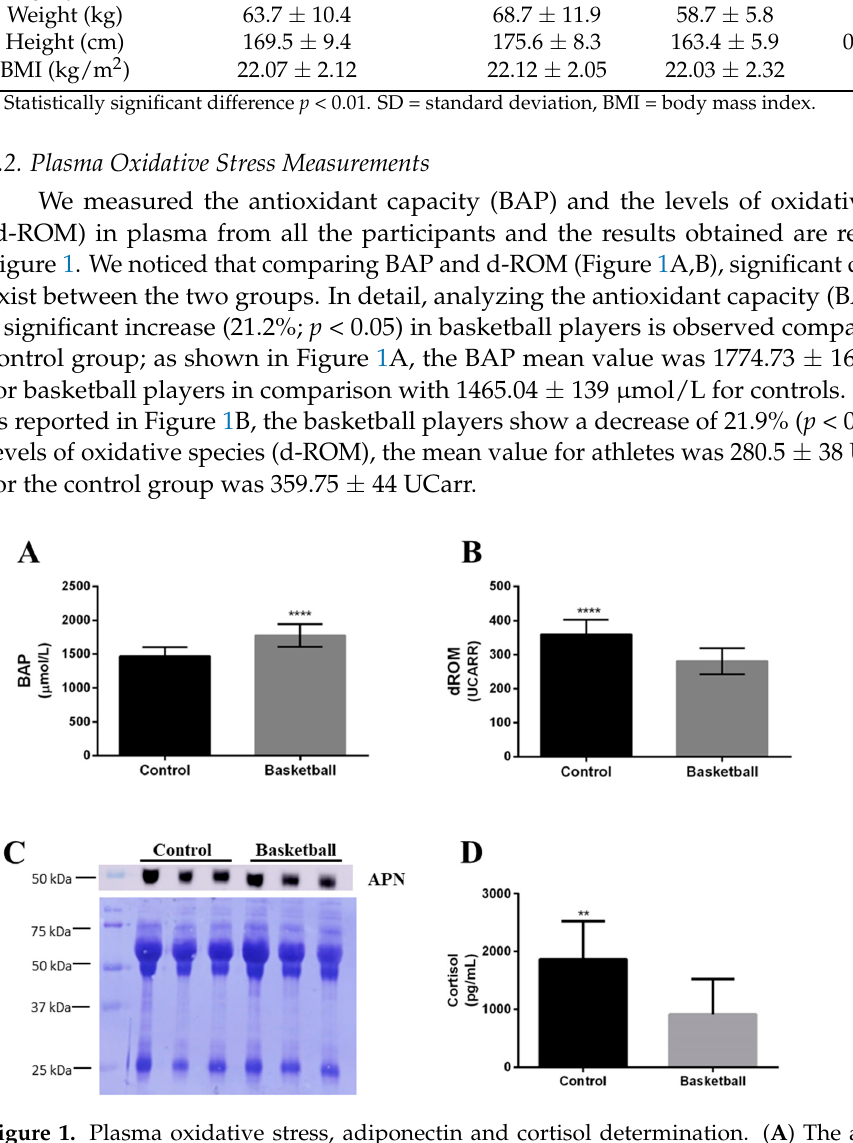
Figure 1. Plasma oxidative stress, adiponectin and cortisol determination. ( A ) The antioxidant capacity was evaluated using the BAP Test (Biological Antioxidant Potential), and ( B ) the levels of reactive oxygen metabolites using the d-ROM test (diacron-Reactive Oxygen Metabolite) by a free radical analyzer system (FREE Carpe Diem, DIACRON INTERNA- TIONAL s.r.l). ( C ) A representative immunoblot of adiponectin is shown together with the corresponding Coomassie- stained PVDF membrane. ( D ) Cortisol levels measured using enzyme-linked immunosorbent assay kit. All the measure- ments ( n = 10 Control and 10 basketball) were performed in triplicate and are reported in the histograms as mean ± SD. The statistical analysis was carried out by two-tailed t-test using Graphpad Prism 8 (** p < 0.01; **** p <